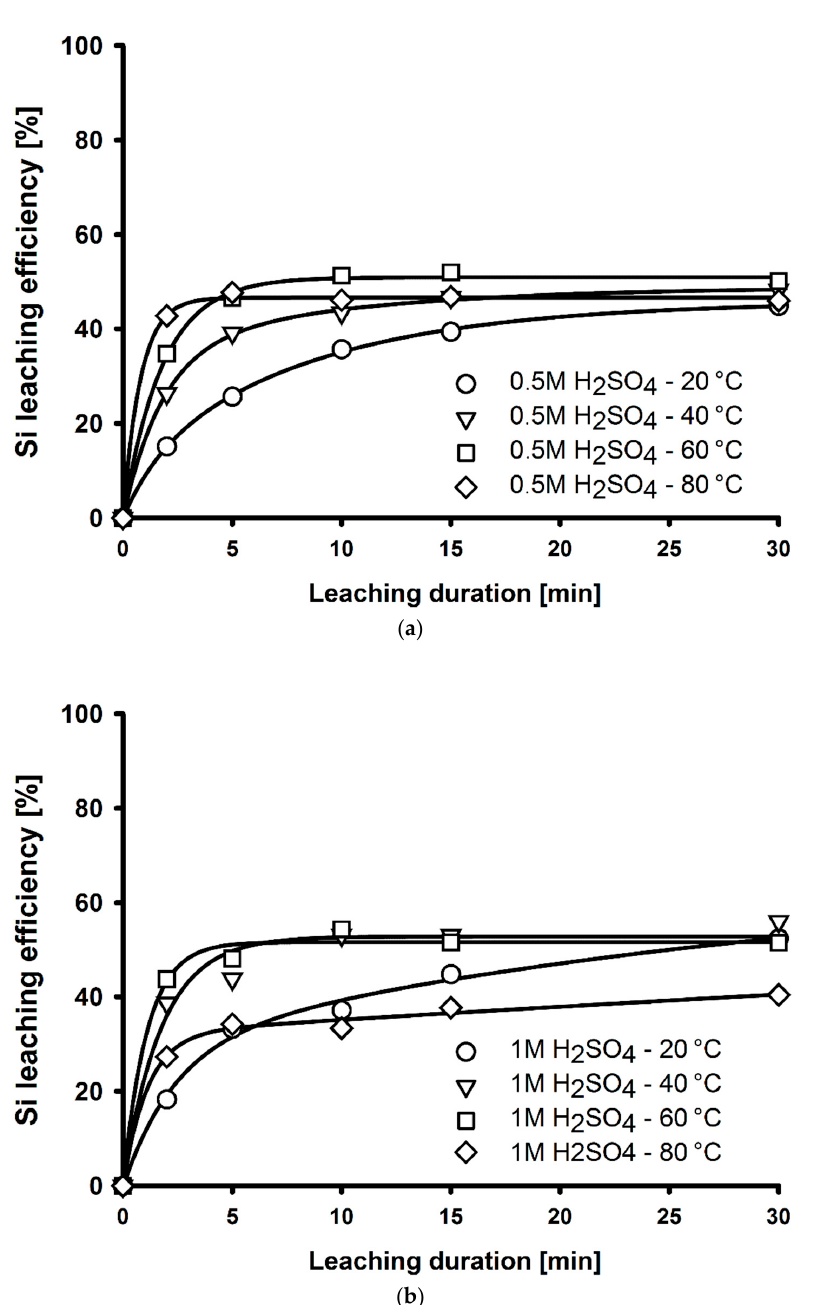
Figure 9. Silicon leaching efficiency at 20–80 °C in 0.5 M ( a ) and 1 M ( b ) H 2 SO 4 .